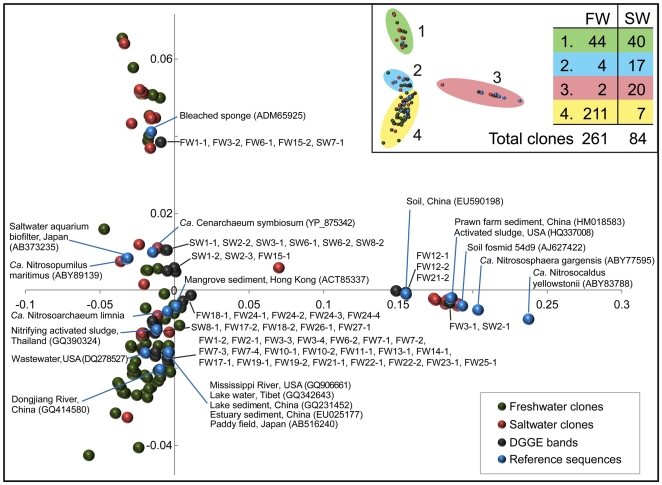
NMDS ordination of translated thaumarchaeal amoA gene sequences.Sequences were obtained from clone libraries and DGGE bands derived from freshwater and saltwater aquarium filter samples. The inset panel provides a summary of the number of freshwater and saltwater clone library sequences contained within each cluster. Sequences obtained from DGGE bands correspond to the white triangles in Figure 3, and are labelled with sample and band numbers. Selected Genbank sequences from uncultivated clones and reference strains are included for comparison. The sampling environment and Genbank accession numbers for all reference sequences are included within parentheses.